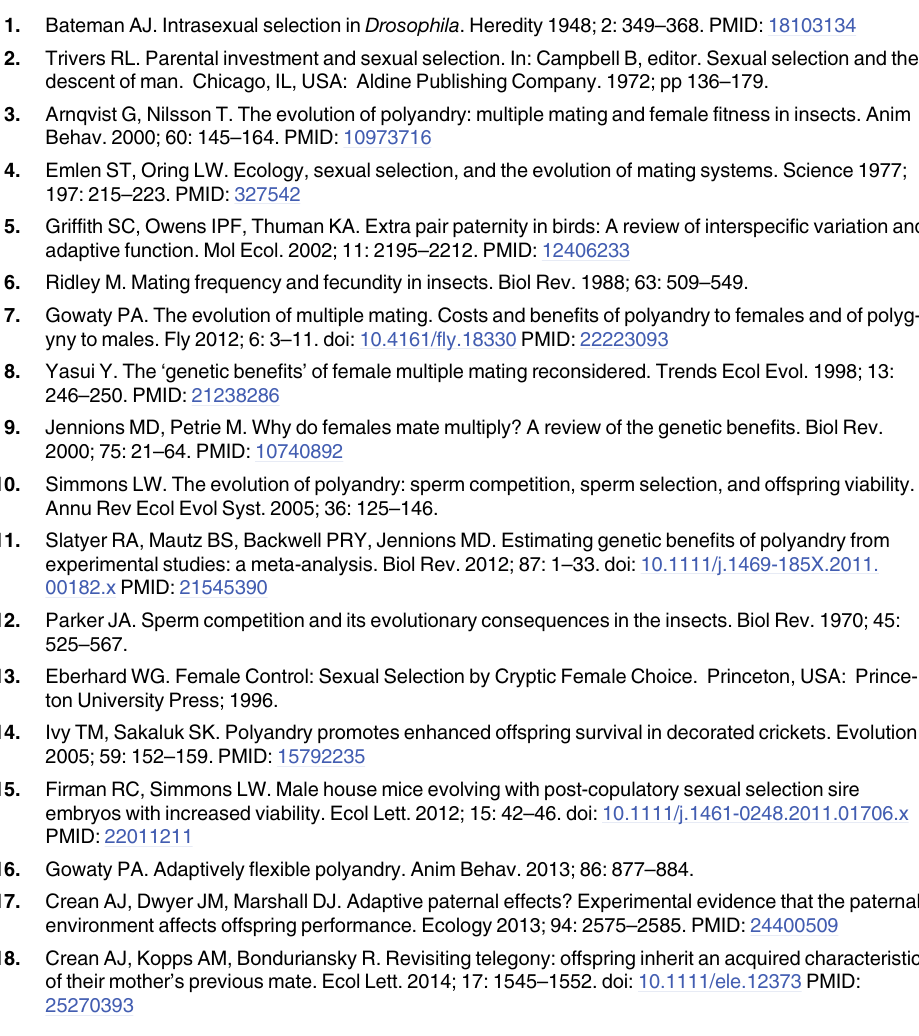
S1 Table. Genotypes used for paternity analysis in P . persimilis . S2 Table. Genotypes used for paternity analysis in N . californicus